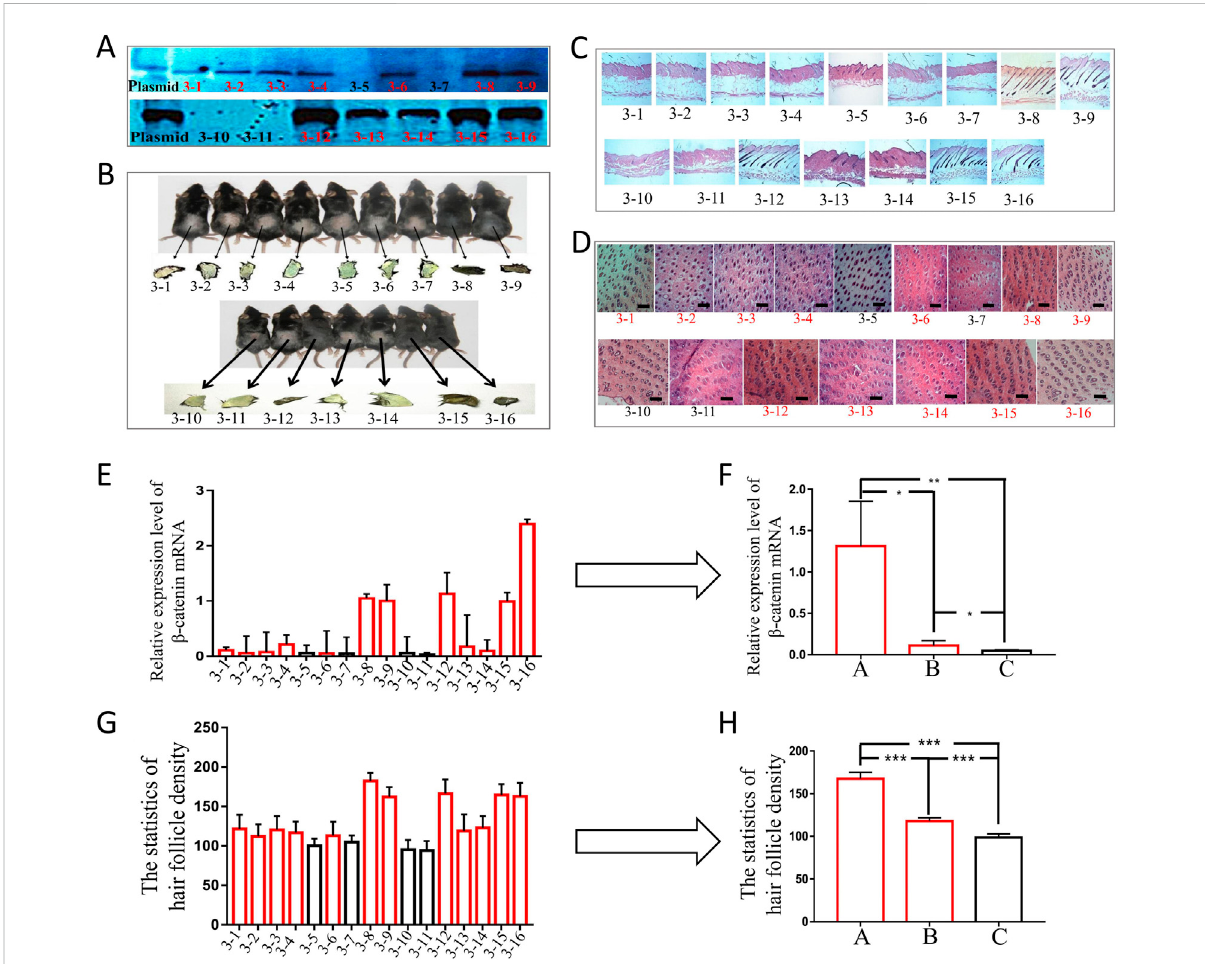
FIGURE 5 ThephenotypicanalysisofF6transgenicmicebyoverexpressingovine β -catenin. (A) Southern-blotoftwotransgenicfamilies,thethickerblack bands represent higher copy number of foreign gene (ovine β -catenin) while the thinner bands represent lower copy number of ovine β -catenin. (B) The two transgenic families of mice and their skin color. (C) The longitudinal slices of transgenic mice skin of the two families. (D) The transection sectionsoftransgenicmiceskinofthetwofamilies,thescalebar:600 μ m. (E) Theexpressionlevelof β -cateninmRNAintransgenicmiceofthe two families. (F) The analysis of β -catenin mRNA levels of transgenic mice that were divided into three groups (A: high copy number group, (B) low copy number group and (C) non-transgenic siblings). *, p < 0.05; **, p < 0.01. (G) Statistical analysis of hair follicle density in transgenic mice of the two families. (H) The analysis of hair follicle density of transgenic mice that were divided into three groups (A: high copy number group, (B) low copy number group and (C) non-transgenic siblings). ***, p <